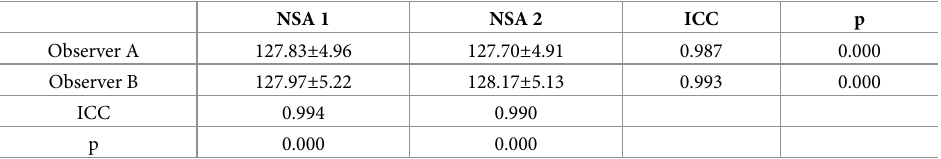
Table 1. Intraclass correlation coefficient(ICC) of measurements.